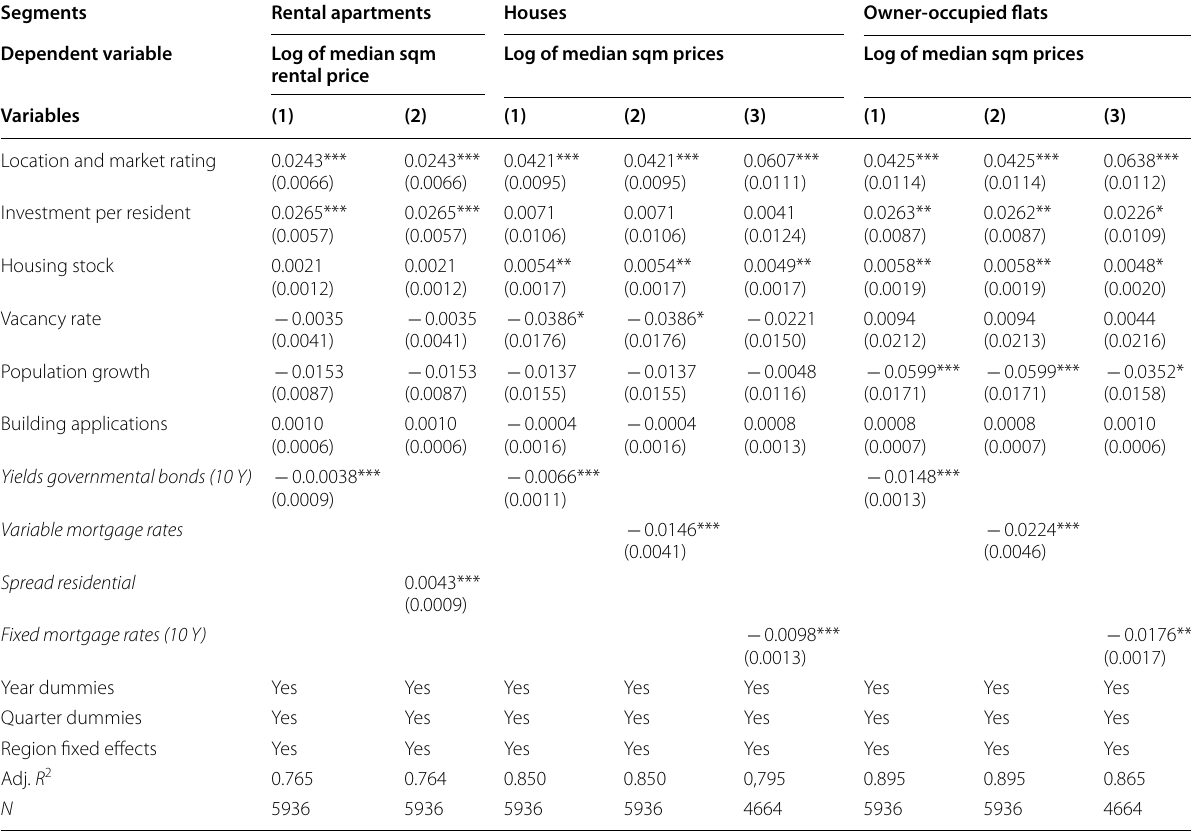
Table 5 Fixed-effect panel regression—residential